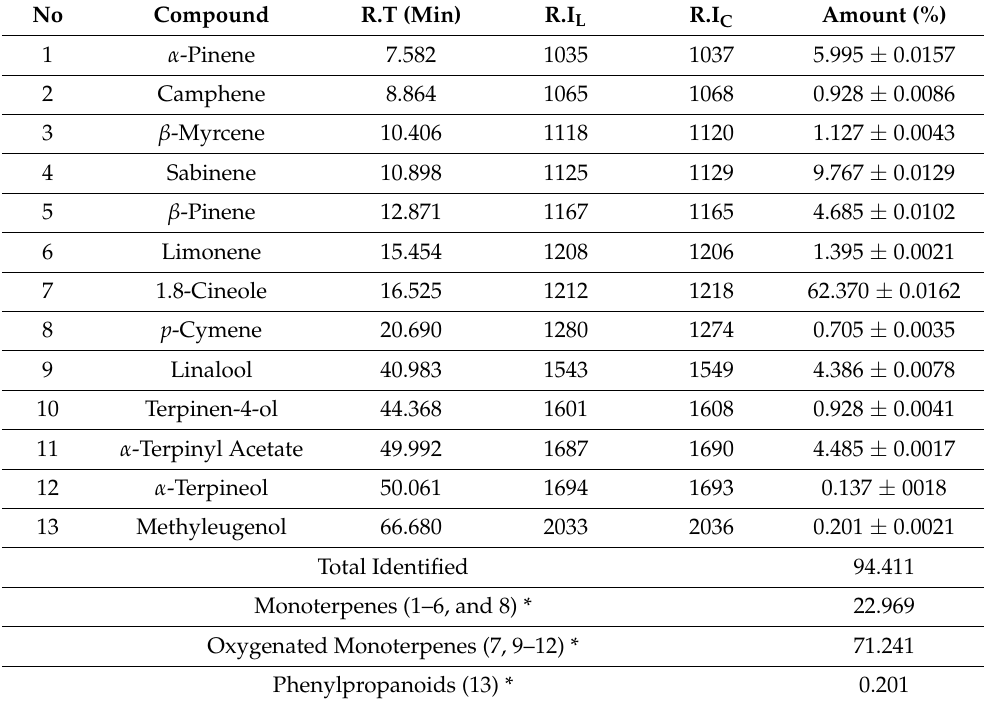
Table 1. Composition of Laurus nobilis leaf essential